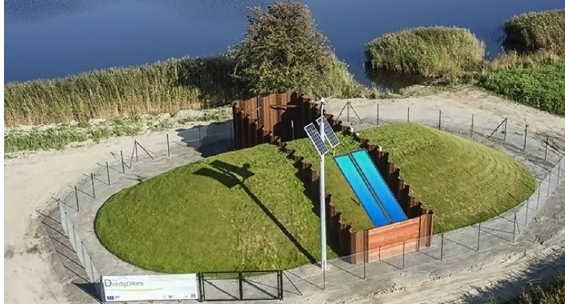
Fig. 3. Gdansk research dike with test section and location of flume 1 (right) and flume 2 (left)